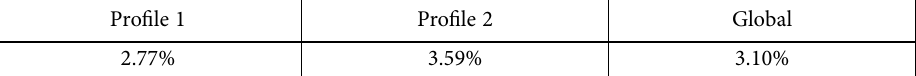
Table 6. Lack of liquidity for a family. Probability (%) with RM (source: own elaboration) Profile 1 Profile 2 Global 2.77% 3.59% 3.10%